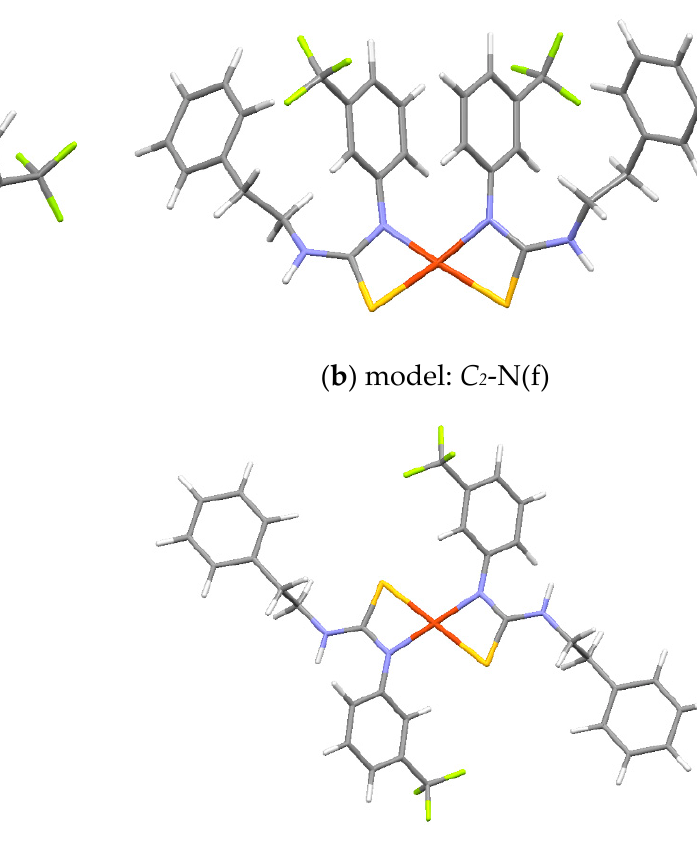
Table 3. DFT geometry optimization results for considered mononuclear models of Cu1 complex. The most energy-stable model is marked in bold.